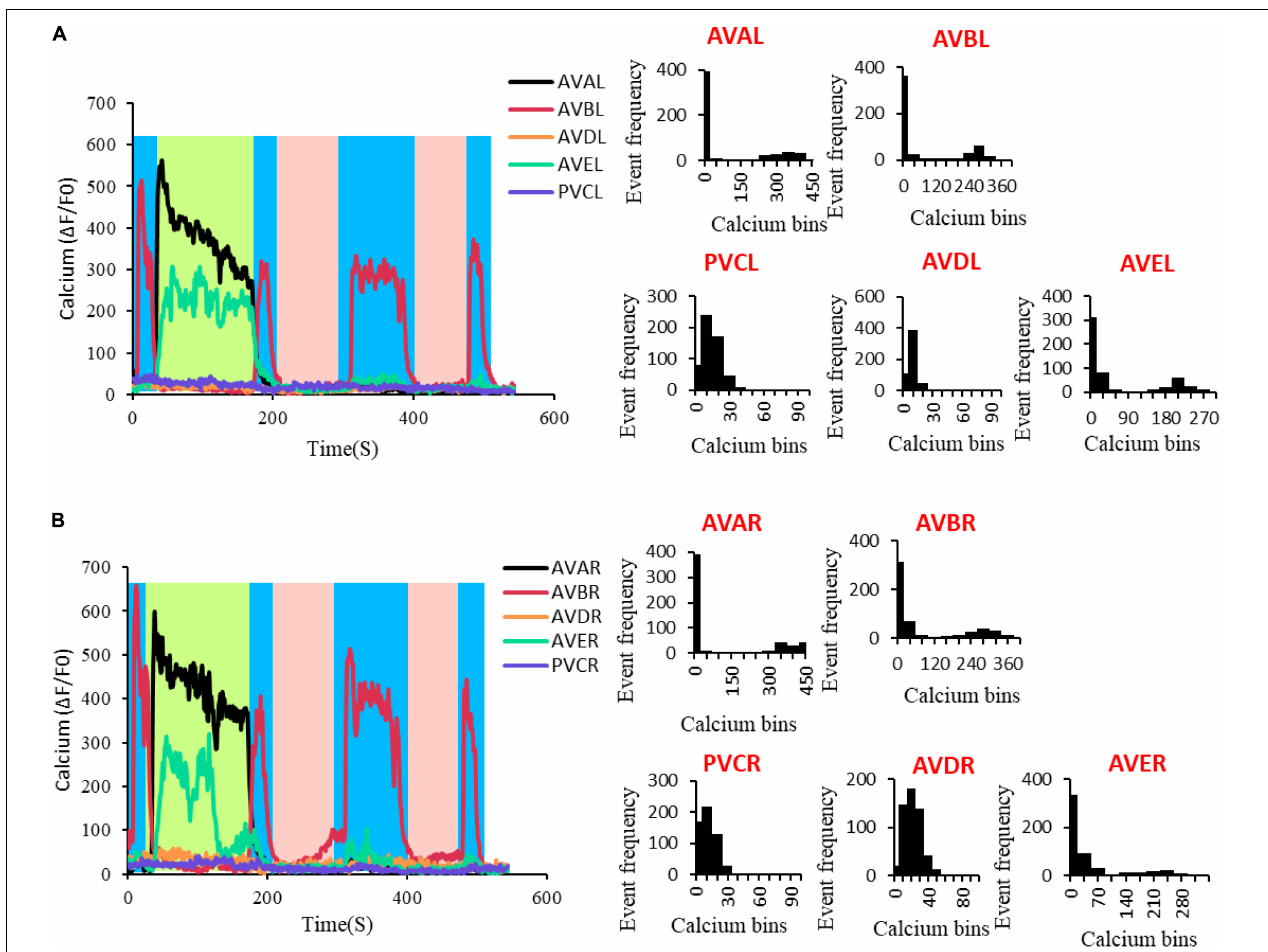
FIGURE 2 | Multiple states in C. elegans neural activity. (A) The neural activity of AVAL, AVBL, AVDL, AVEL, and PVCL. The graph at the left of the panel is the neural activity changes with time, in which the blue area represents the period when AVBL was in high neuro activity, the light green area represents the period when AVAL and AVEL were in high neuro activity, and the pink area represents the period when all the neurons were in low neuro activity. The other demonstrated the distribution of the neural activity changes. AVAL, Bin size = 50; AVBL, Bin size = 40; AVDL, Bin size = 9; AVEL, Bin size = 30; PVCL, Bin size = 9. (B) The neural activity of AVAR, AVBR, AVDR, AVER, and PVCR. The graph at the left of the panel is the neural activity changes with time, in which the blue area represents the period when AVBL was in high neuro activity, the light green area represents the period when AVAL and AVEL were in high neuro activity, and the pink area represents the period when all the neurons were in low neuro activity. The other graphs demonstrated the distribution of the neural activity changes. AVAR, Bin size = 50; AVBR, Bin size = 40; AVDR, Bin size = 10; AVER, Bin size = 35; PVCR, Bin size =